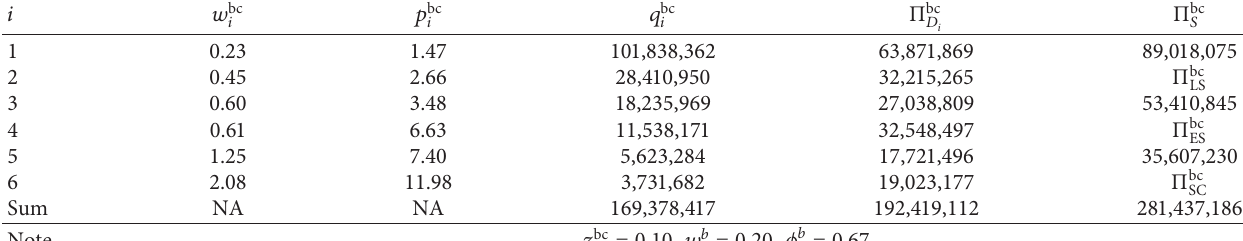
Table 7: Numerical analysis results of coordination decision with partial